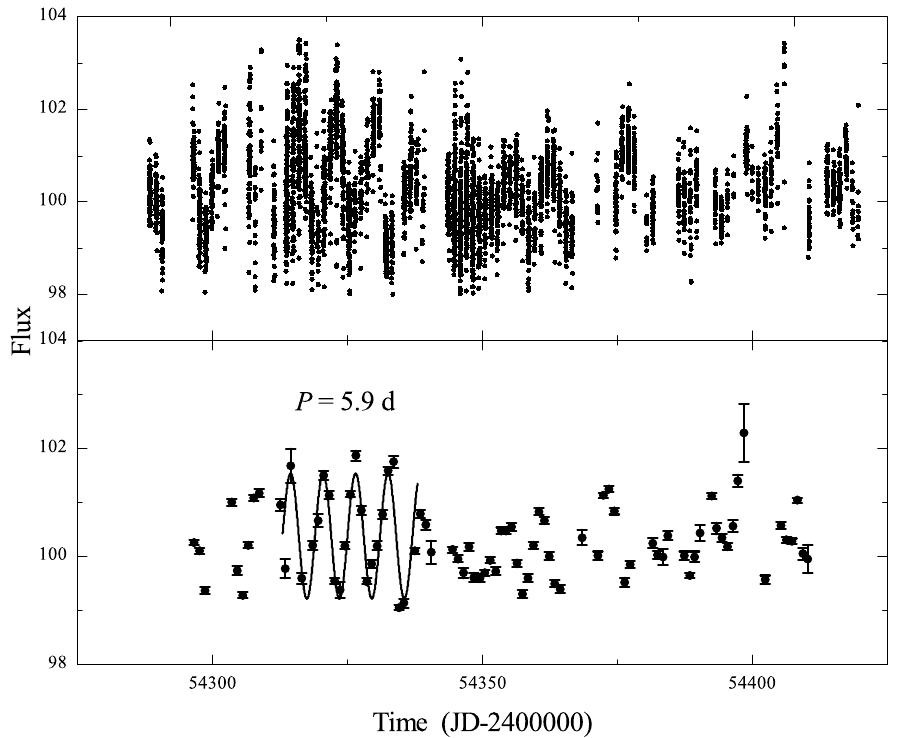
Fig. 4. SuperWASP photometry of BD+20 5152 obtained in 2007. In the upper panel, individual measures are given. The lower panel shows the averaged fluxes for each night and the fitted curve during the period of strongest